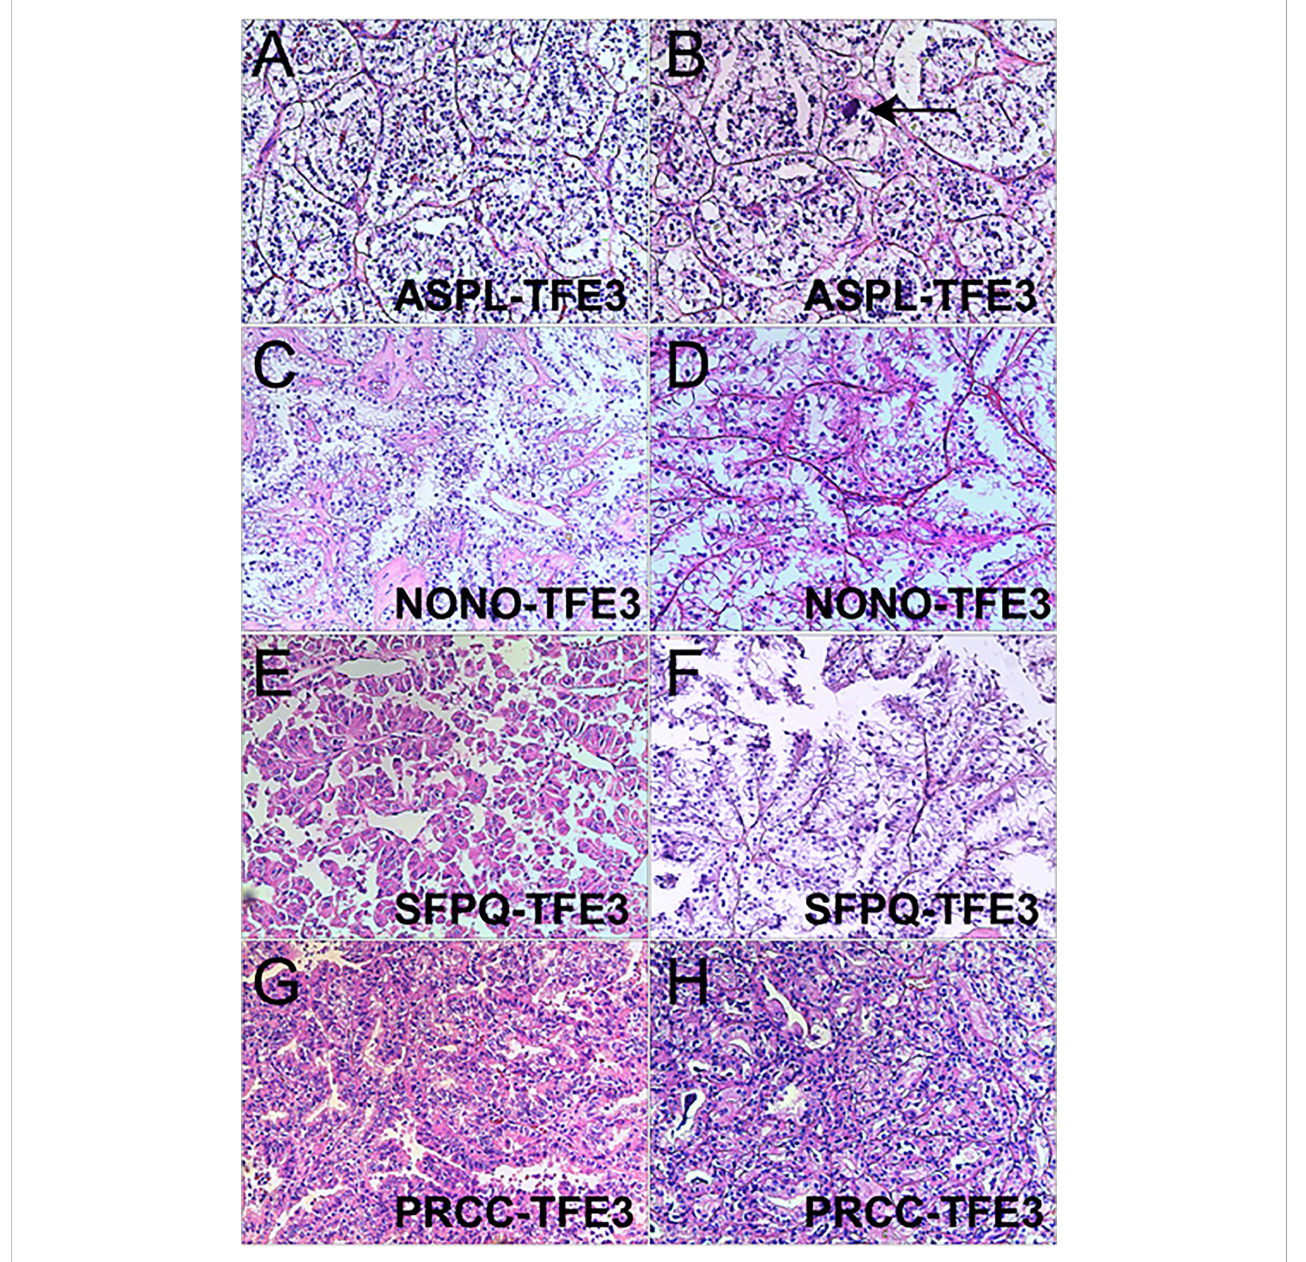
FIGURE 1 Representative images of morphologic features in Xp11.2 tRCCs with four common fusion subtypes. (A, B) ASPL-TFE3 cases showed nested architecture, clear to eosinophilic cells with voluminous cytoplasm and round nuclei, Psammoma bodies were frequently seen (arrowhead). (C, D) NONO-TFE3 cases showed papillary architecture with clear to fl occulent eosinophilic cytoplasm. (E, F) SFPQ-TFE3 cases showed papillary architecture. (G, H) PRCC-TFE3 showed compact architecture with less voluminous cytoplasm. Original magni fi cation: × 100 (A – H) . H&E: hematoxylin and